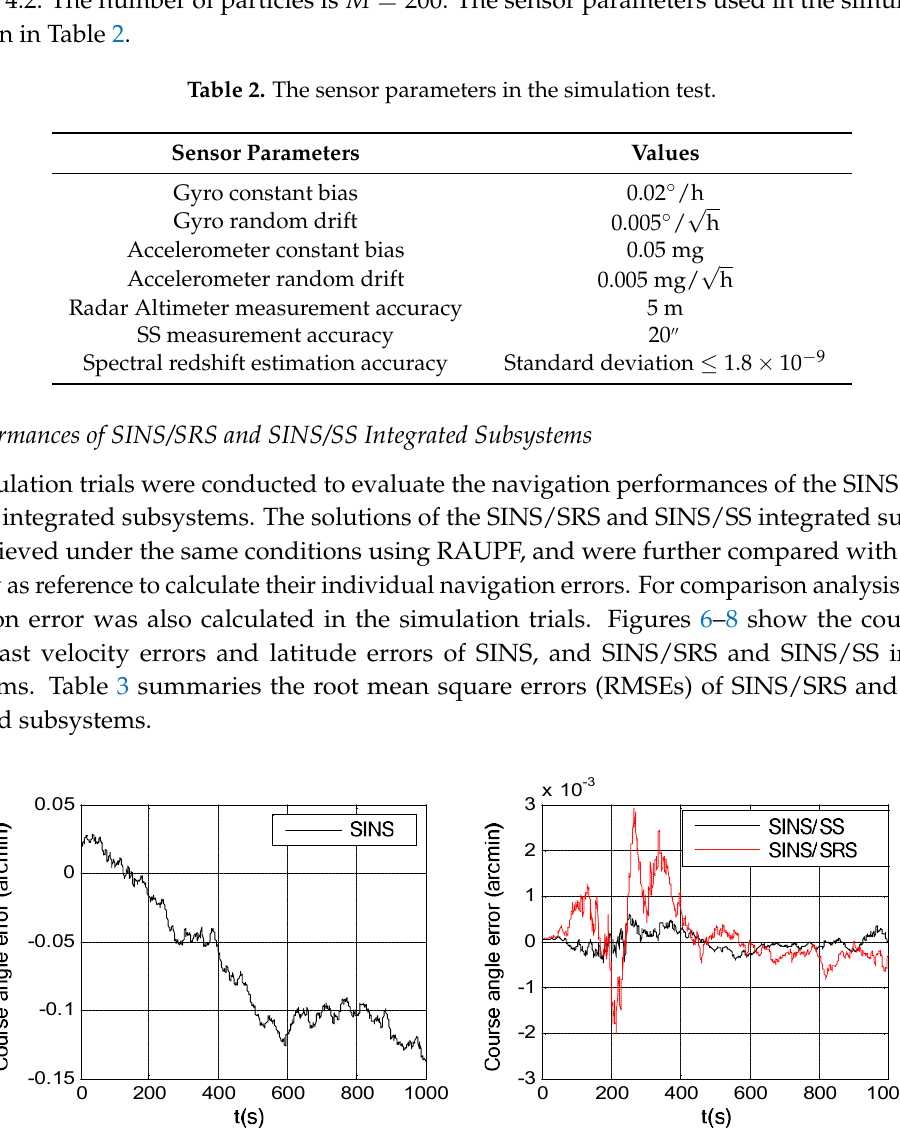
Figure 6. Course angle errors of SINS as well as SINS/SRS and SINS/SS integrated subsystems.